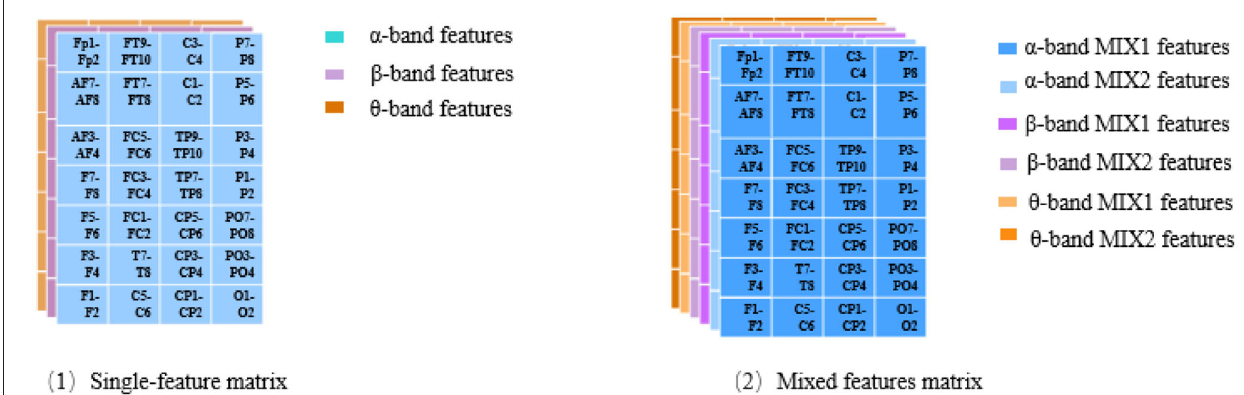
FIGURE 4 | Structure of the feature